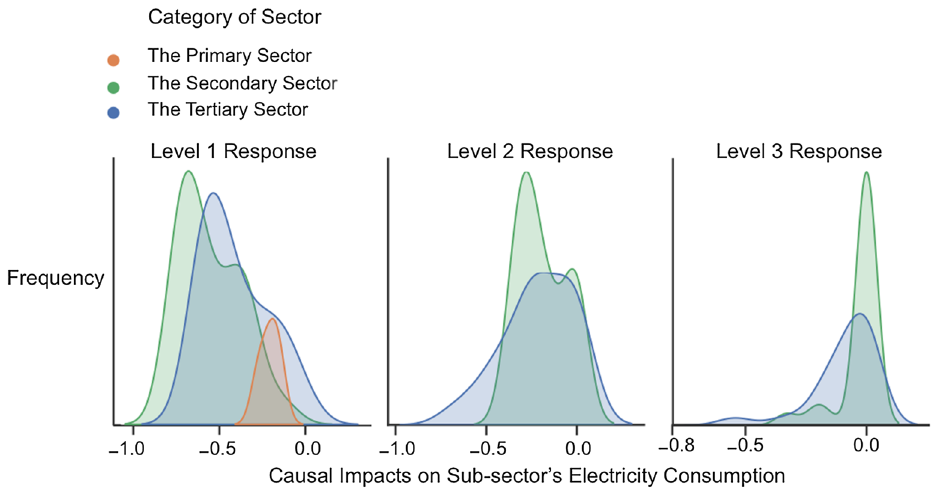
Figure 5. Distribution of causal impacts on three main economic sectors: kernel density estimate (KDE) plot represents the DID estimation results using continuous probability density curves. The data covers the multi- period causal effects of 53 sub-sectors which are classed as three main economic